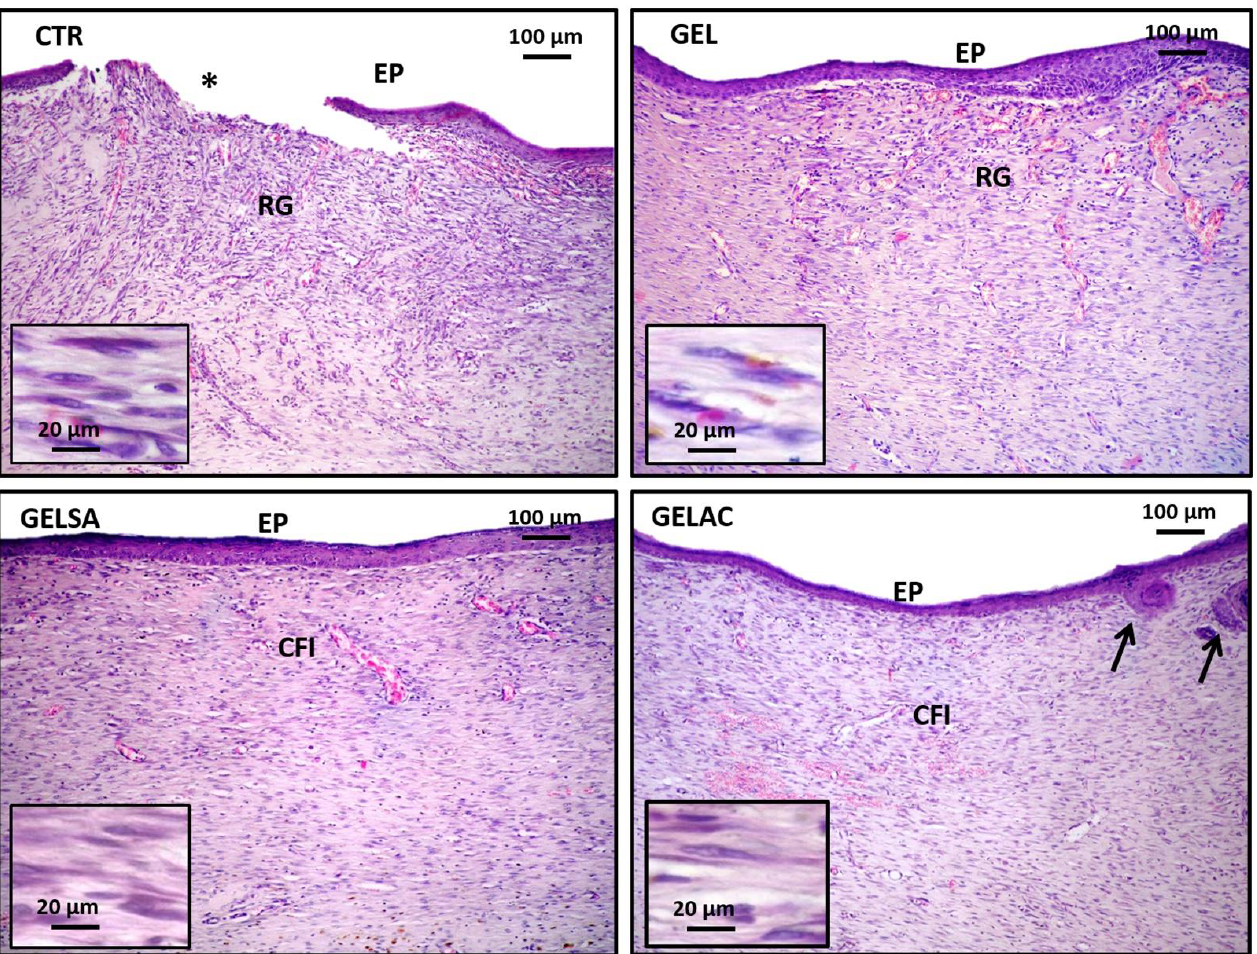
Figure 13. Photomicrographs of HE-stained histological sections representative of the 14-day repair process. CTR shows a residual granulation reaction arranged in a still well-vascularized surface band and areas of incomplete epithelialization (100 × ). (400 × ). GEL exhibits residual granulation reaction also richly vascularized, but with complete epithelialization (100 × ). GELSA and GELAC present an immature, hypovascularized, and richly cellular fibrous scar (100 × ). Notes formation of marginal epithelial buddings compatible with rudimentary skin appendages in GELAC (arrows). Highlights show details of the spindle cells and capillaries composing the residual granulation reaction in CTR and GEL and of the predominant spindle cell component in the immature fibrous scar in GELSA and GELAC (400 × ). Caption: CTR—control group; GEL—group treated with gelatin biomembranes only; GELSA—group treated with gelatin biomembranes containing S. adstringens extract; GELAC—group treated with A. cochliacarpa extract; GR—granulation reaction; PE—keratinized stratified squamous epithelium (epithelialization); IFC—immature fibrous scar; (*)—area of denudation of connective tissue resulting from incomplete